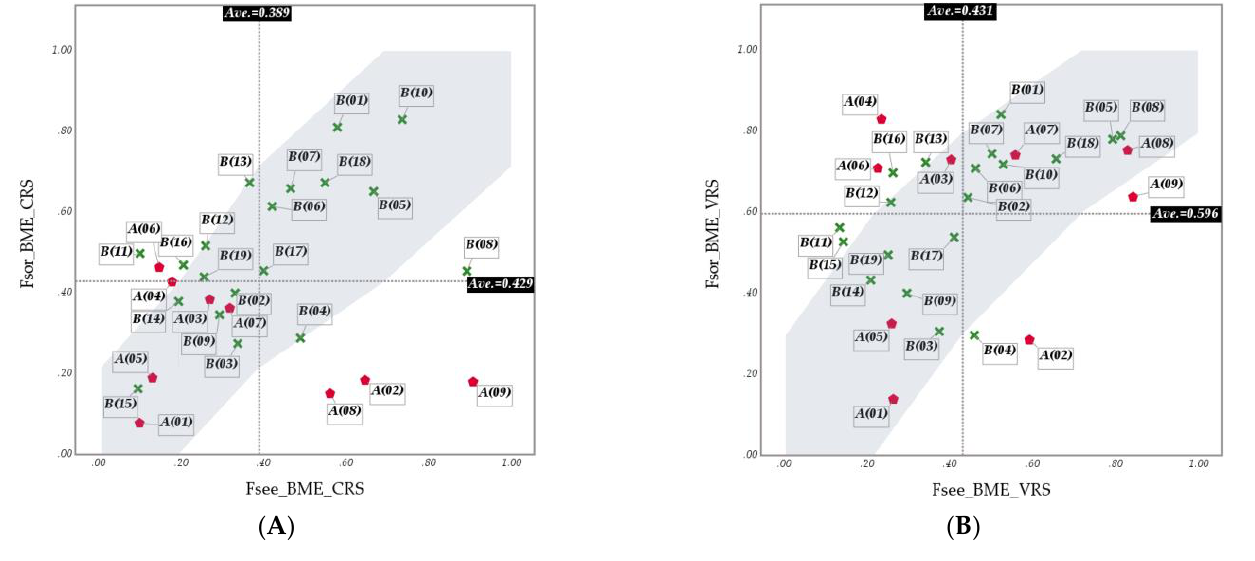
Figure 4. BME difference between franchisors and franchisees. : Premium Group, : Mainstream Group; ( A ) CRS-based assumption; ( B ) VRS-based assumption.